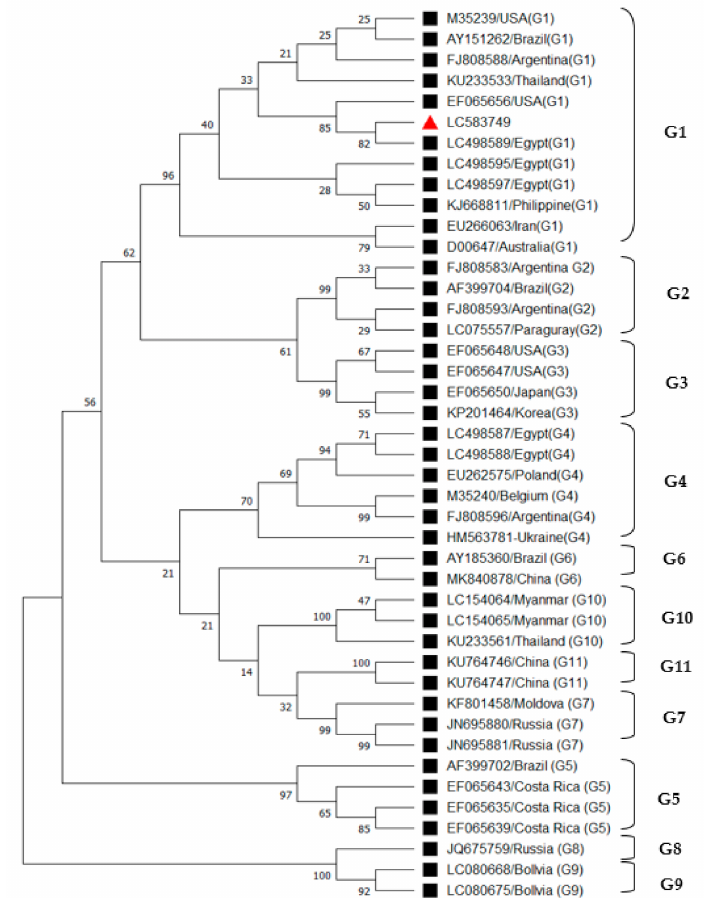
Figure 2. Phylogenetic tree based on env gene for Egyptian Bovine leukemia virus (BLV) and other reference strain in the